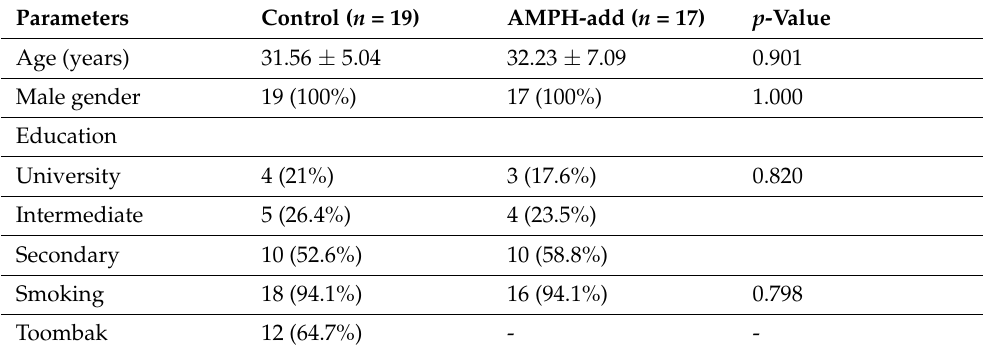
Table 1. Sociodemographic characteristics of the AMPH-add participants and control.